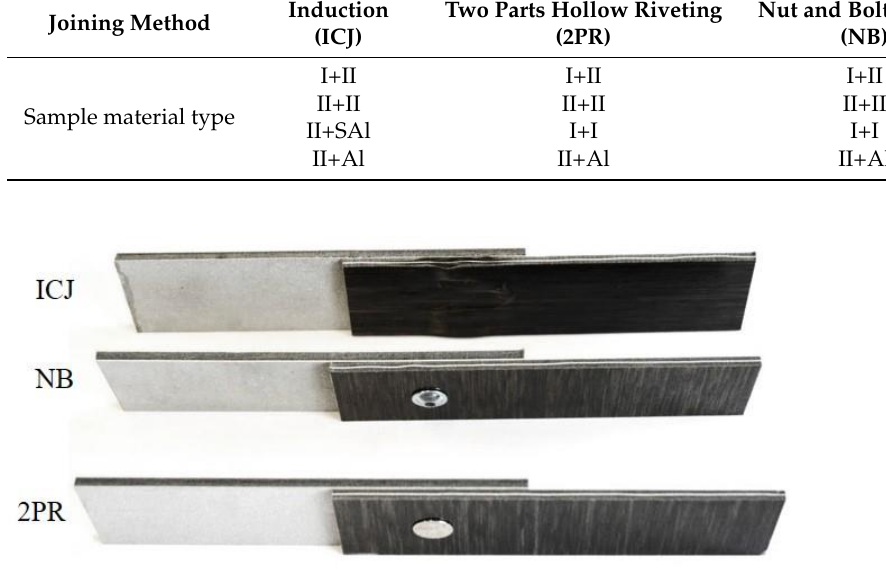
Figure 4. Joining samples of Type I and Type II for the three joining methods. NB: nut and bolt; 2PR: two-piece hollow